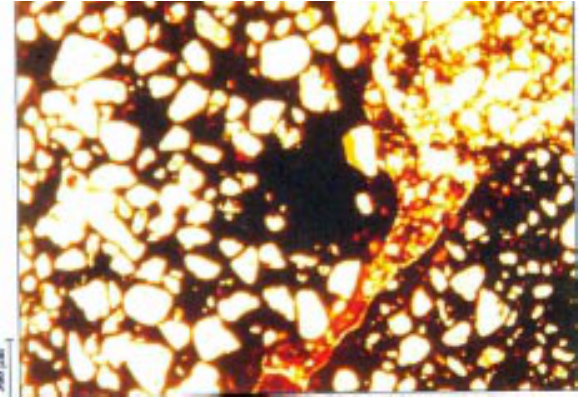
Figura 8. Fotomicrografia mostrando glébulas com diferentes granulometrias do esqueleto presentes lado a lado no horizonte petroplíntico do perfil P2. Luz normal -